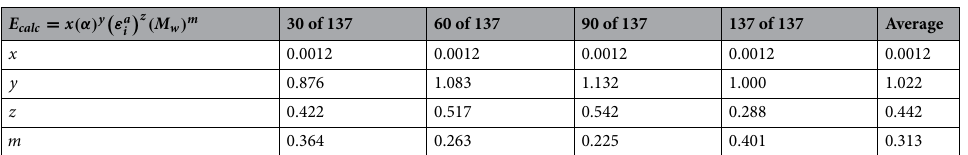
E calc = x (α) y (cid:31) ε a i (cid:30) z ( M w )